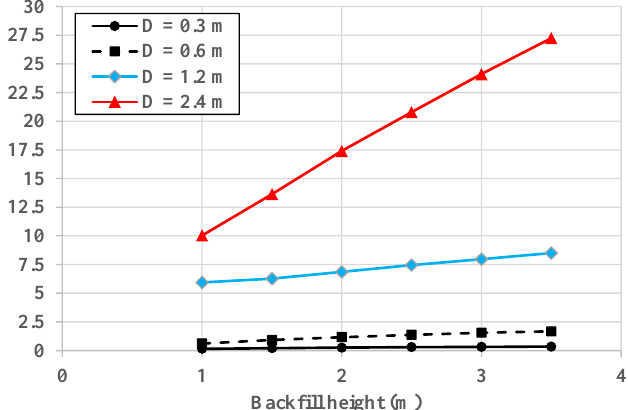
Figure 11. Effect of the pipe diameter and backfill height on the maximum pipe wall bending moment for the CB (SW90).